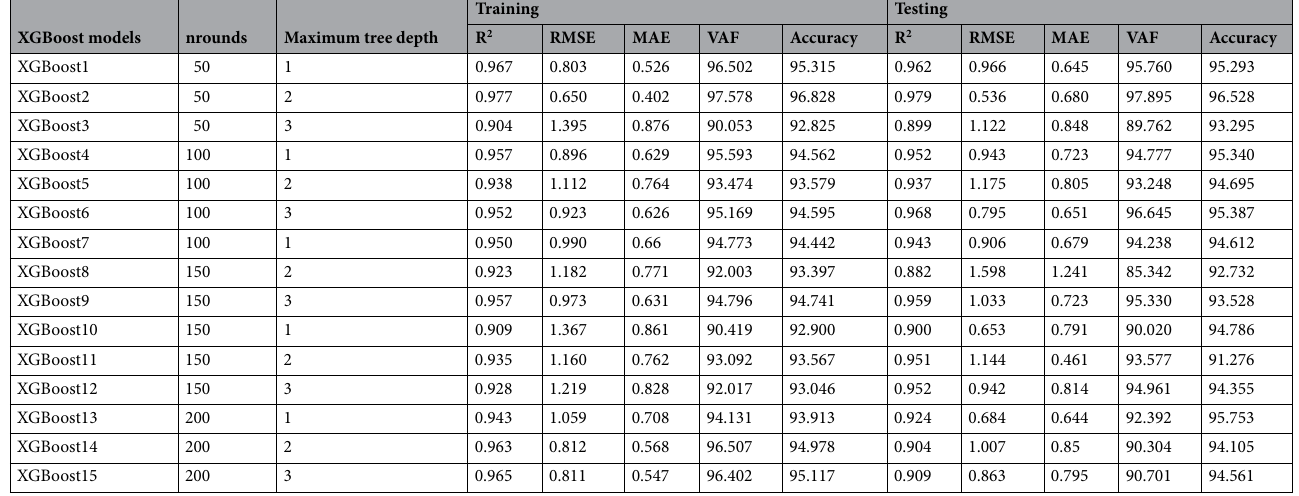
Table 6. The base models of XGBoost and their